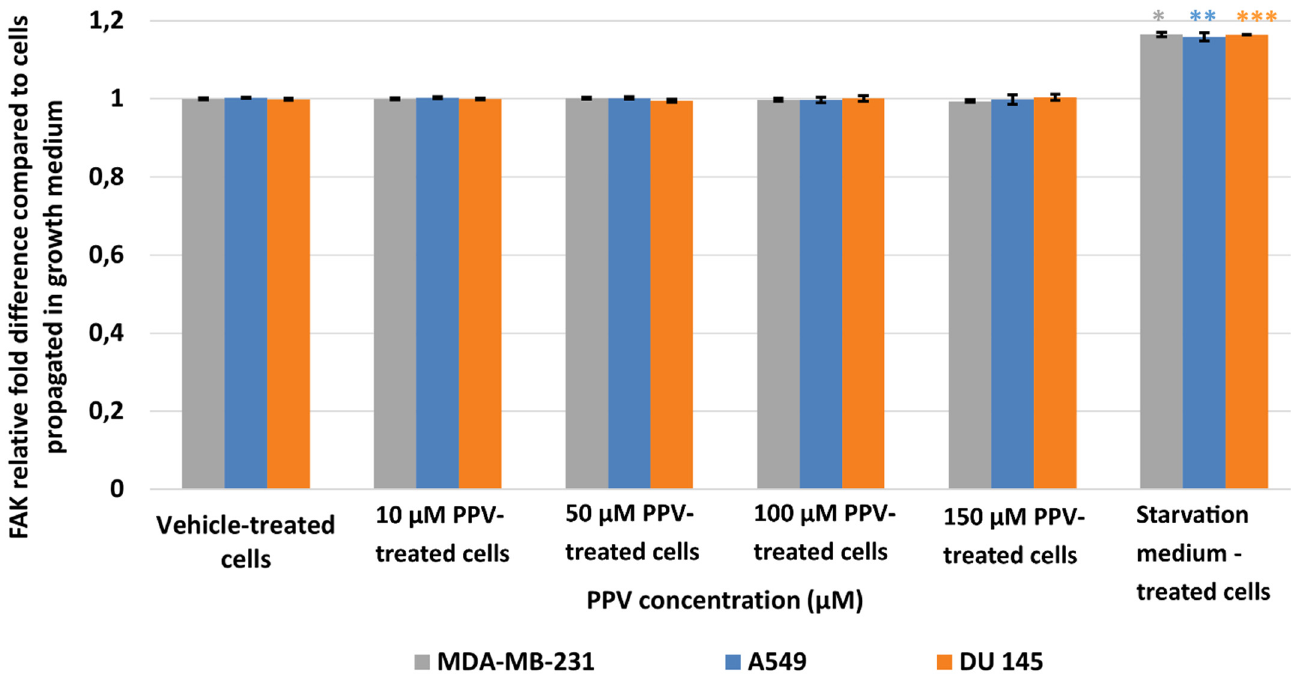
Figure 8. Spectrophotometry results of FAK ELISA demonstrating the effects of PPV (10–300 µ M) on proliferation on MDA-MB-231 cells compared to A549- and DU145 cell lines at 48 h. The average of there independent experiments is represented by the graph with error bars indicating standard deviation. The statistical significance of MDA-MB-231 cells is indicated with an asterisk (*), the statistical significance of A549 cells is indicated with two asterisks (**), and the statistical significance of DU145 cells is indicated with three asterisks (***). Statistical significance is represented by an * when using the student t -test with a p value of 0.05 compared to cells propagated in complete growth medium.